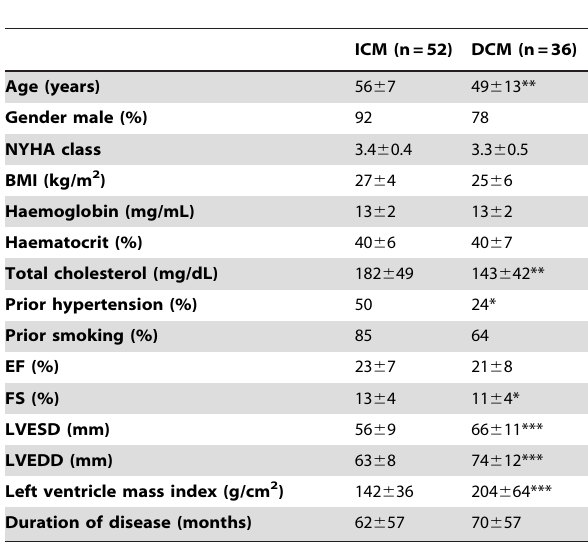
Table 1. Patients characteristics according to HF